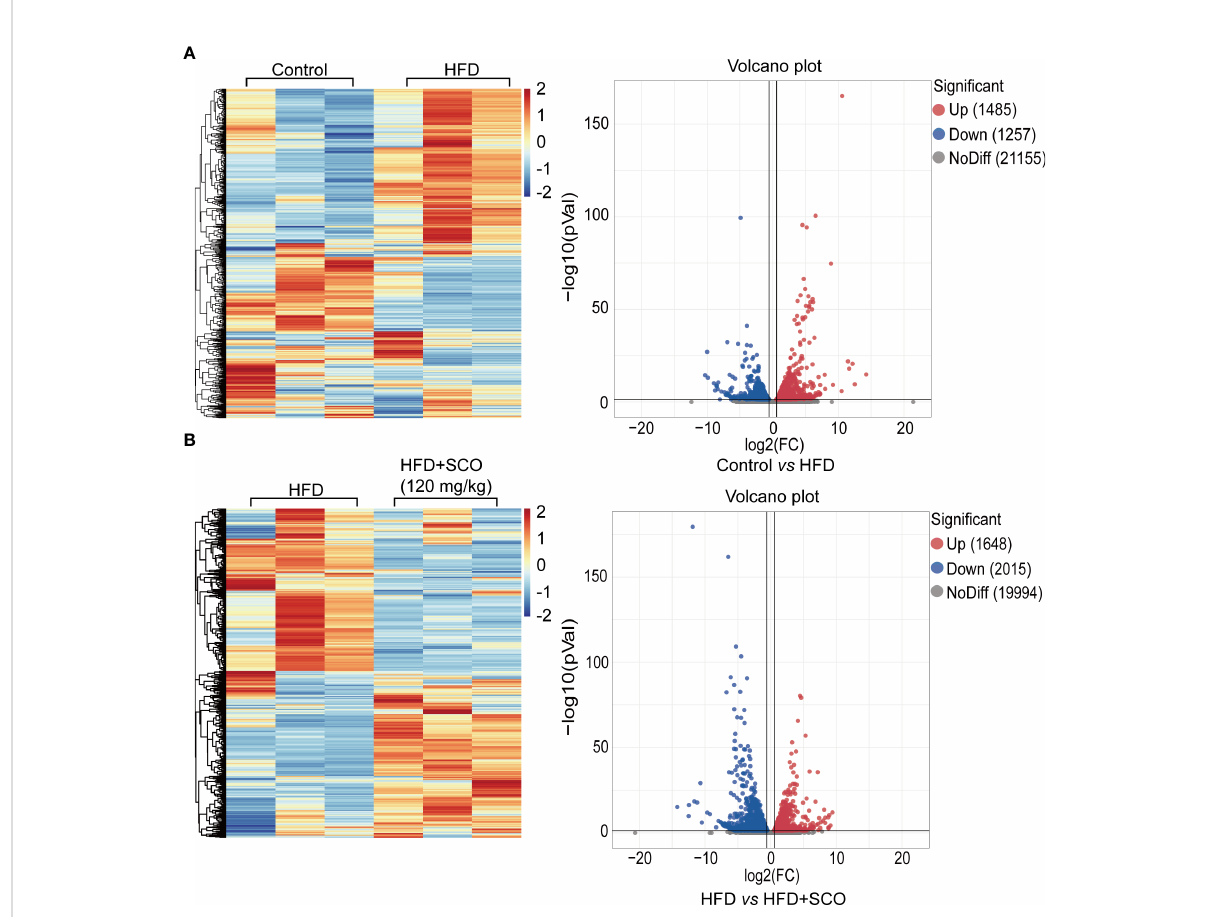
FIGURE 4 The hierarchical cluster analysis and scatter plot of all differentially expressed genes. (A) The Control group vs the HFD group. (B) The HFD group vs the HFD + SCO